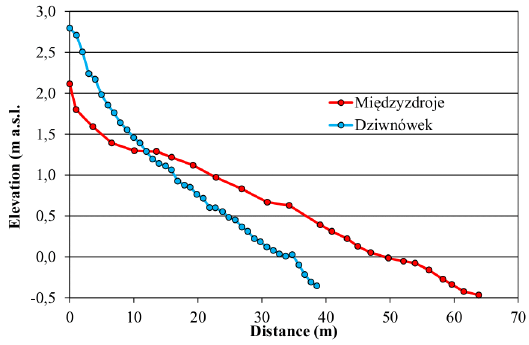
Figure 3. Cross-sections of two beaches in Mie˛dzyzdroje and Dziwno´wek.